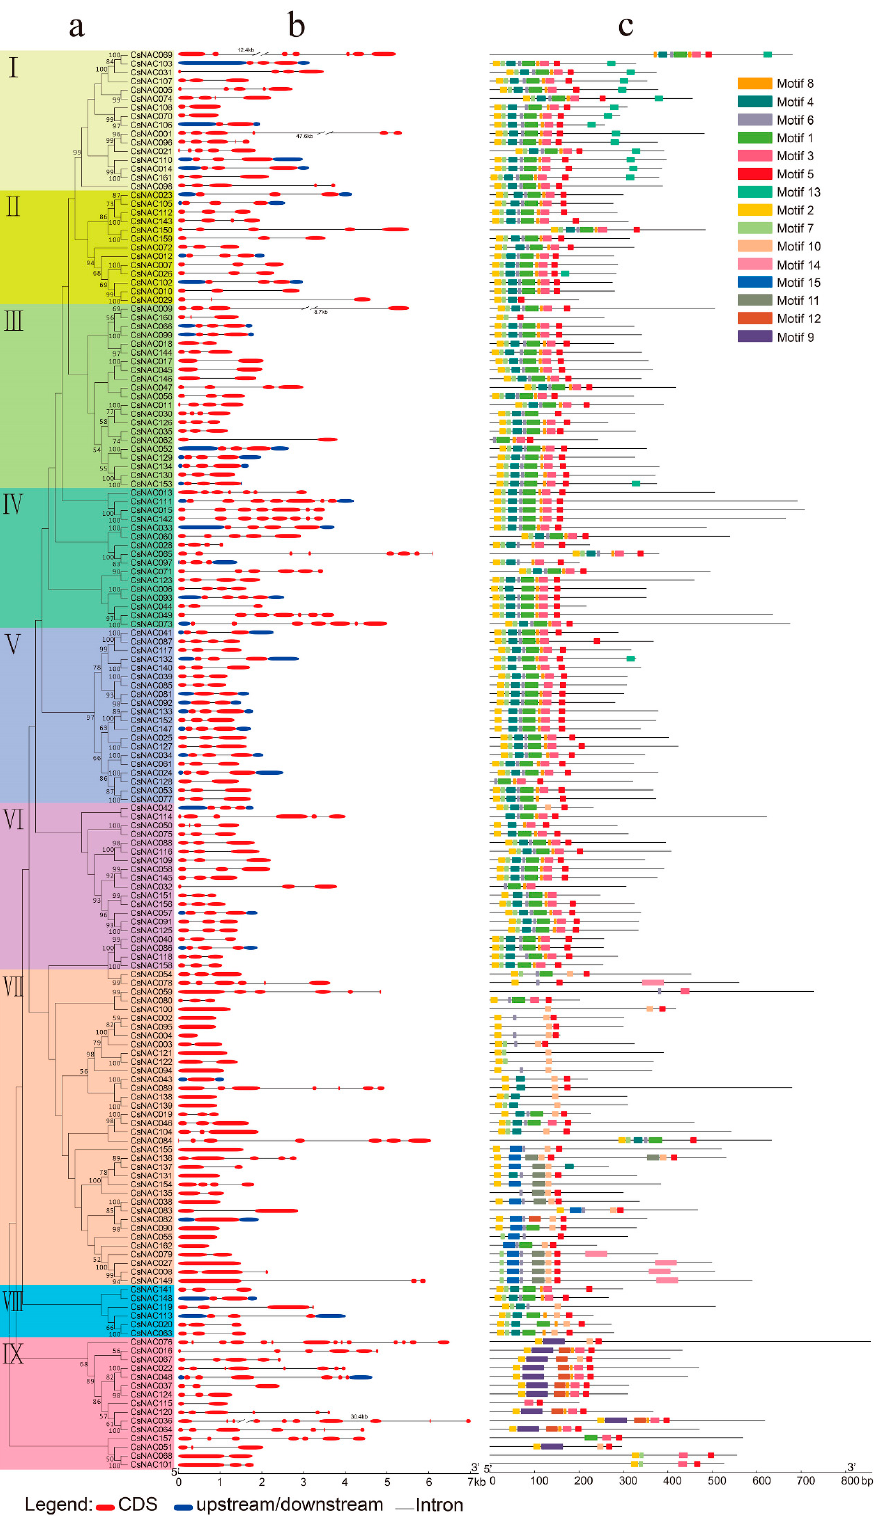
Figure 4. Phylogenetic relationships, gene structure and putative conserved domain distributions of the CsNAC family. ( a ) The phylogenetic tree was constructed with CsNAC protein sequences using MEGA 7 software. The cluster details are indicated in multiple colors. ( b ) Exon–intron structure is indicated by red rectangles and black lines, respectively. ( c ) Multiple colored boxes represent di ff erent motifs. The motif sequence information is provided in Figure